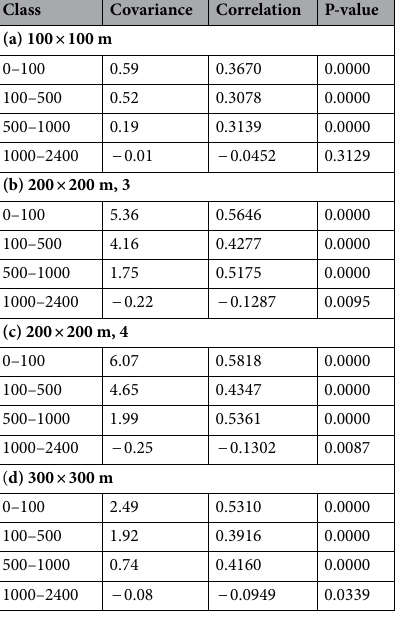
Table 4. Pipe diameter correlation analysis: (a) 100 × 100 m, (b) 200 × 200 m, 3, (c) 200 × 200 m, 4, (d) 300 × 300